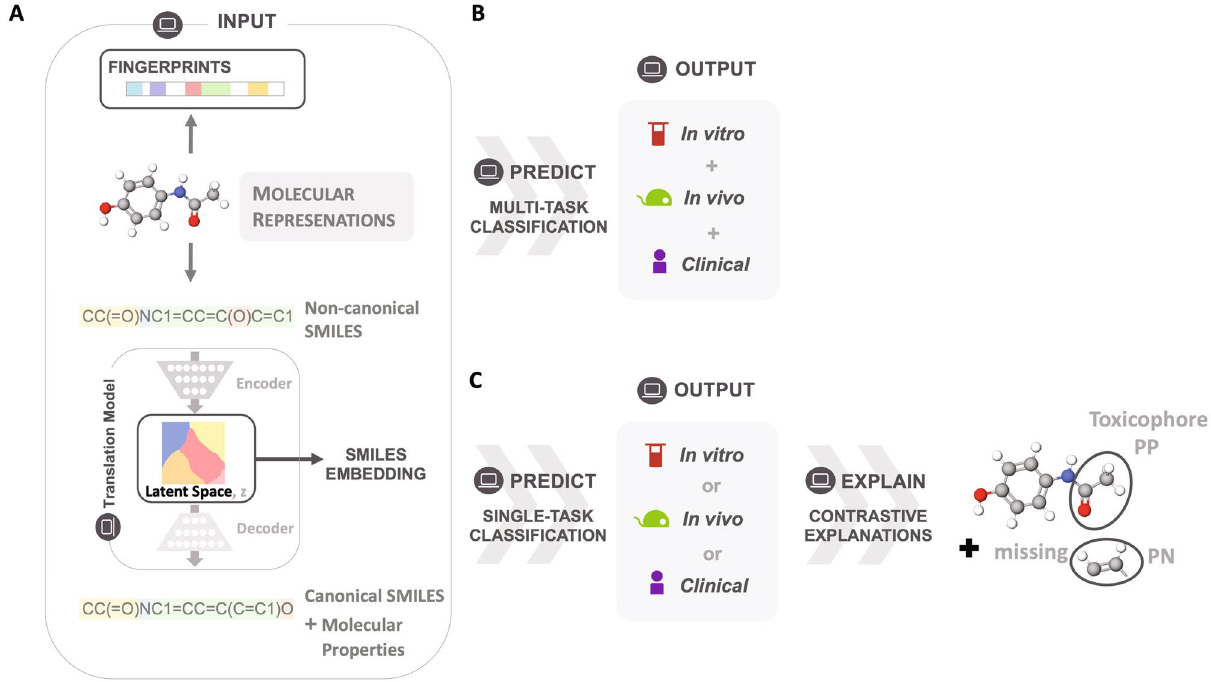
Figure 1. Framework adopted in this study for explainable, single-task, and multi-task prediction of in vitro, in vivo, and clinical toxicity. ( A ) Given an input of different molecular representations, fingerprints and latent space SMILES embeddings, ( B ) a multi-task classification model predicts whether a molecule is toxic or not for in vitro, in vivo, and clinical endpoints. Furthermore, the Contrastive Explanation method explains ( C ) predictions from single-task models trained on fingerprints for the same endpoints. The method pinpoints minimal and necessary chemical substructures that are either present (pertinent positive, PP) or absent (pertinent negative, PN) for a specific